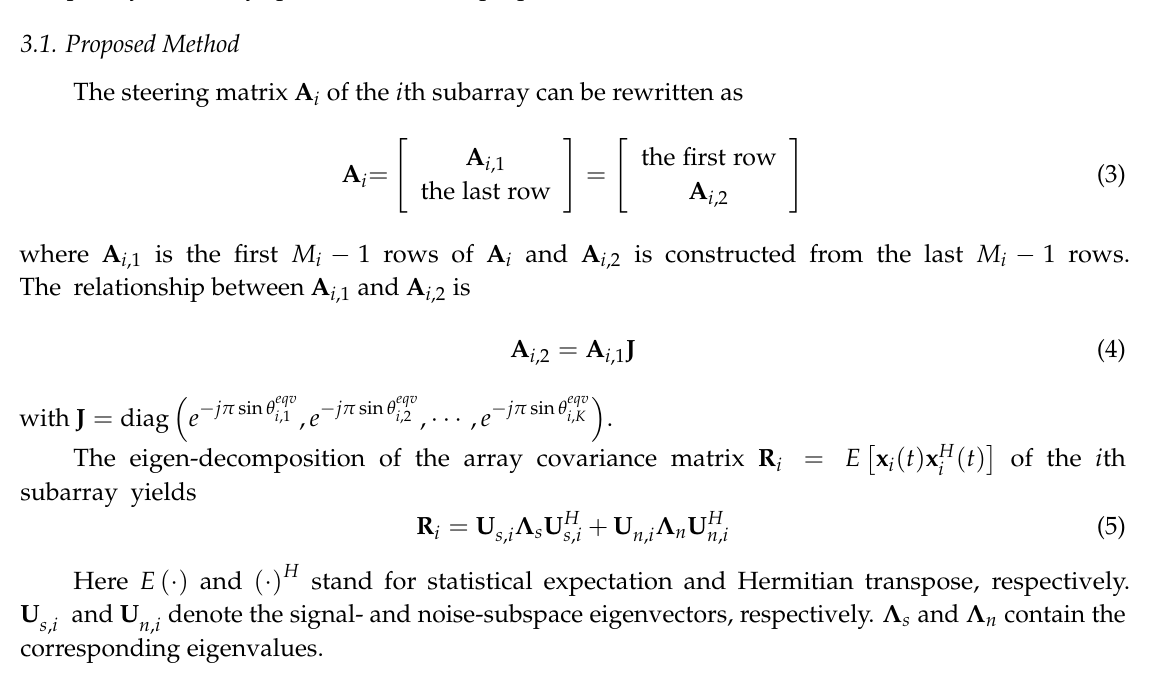
is the equivalent i , k